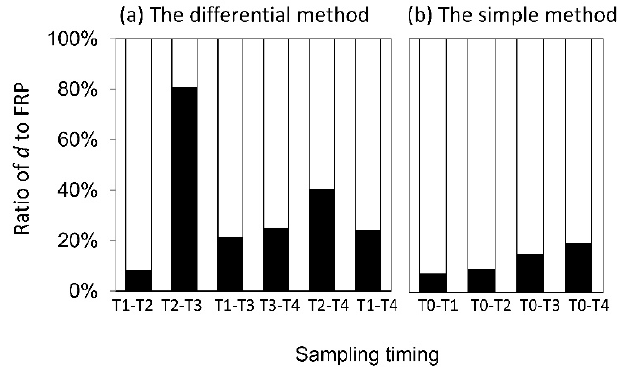
Figure 5. Ratio of decomposed dead fine roots (d) to fine root production (FRP) estimated by ( a ) the differential method and ( b ) the simple method for various sampling times.